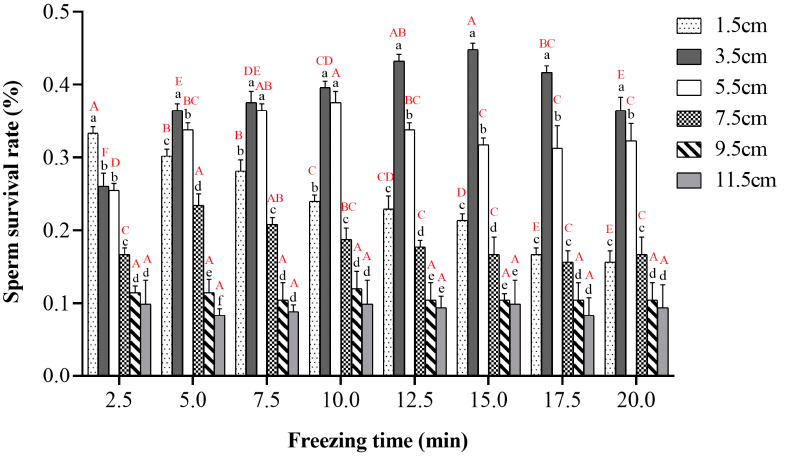
Figure 4. Survival rates of sperm of P. trituberculatus after different cooling procedures on cryopreser- vation. Different lower-case letters indicate significant differences between straws at different heights ( p < 0.05). Different capital letters represent significant differences between different times at the same height ( p < 0.05) ( n = 60).